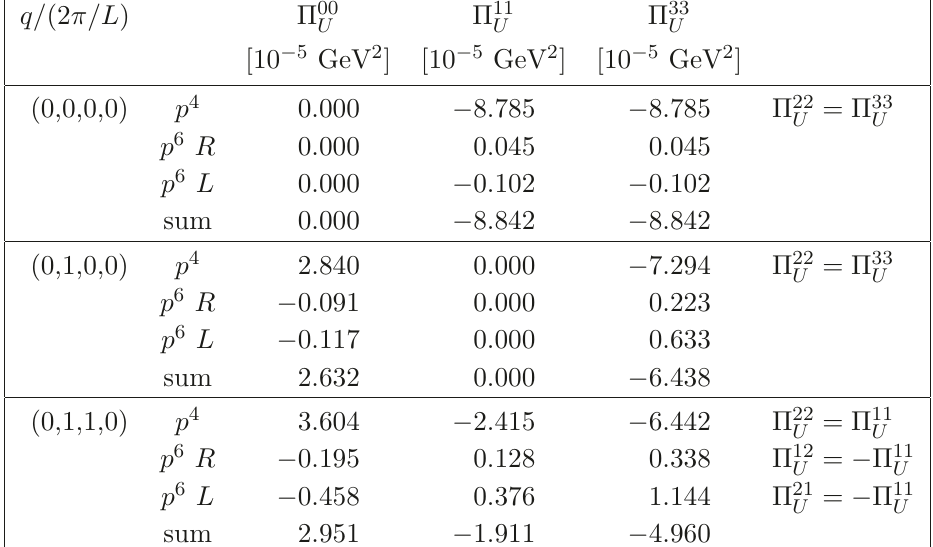
Table 1 . The finite volume corrections to the components of Π µν lying momenta available with periodic boundary conditions. The disconnected part is essentially 1 / 2 the connected part as discussed in the text. The last columns indicate components which are − related to the explicitly presented ones. Components not mentioned are